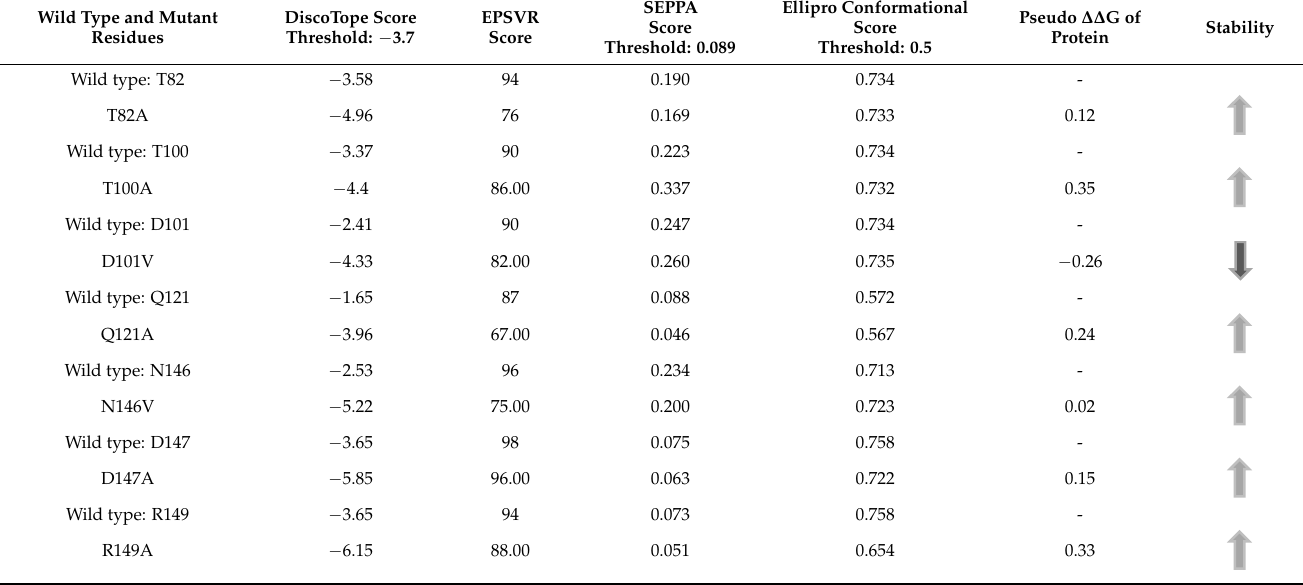
Table 2. Score changes of immunogenic residues according to conformational B-cell epitope predictor servers alongside prediction of overall stability through SDM2 server.